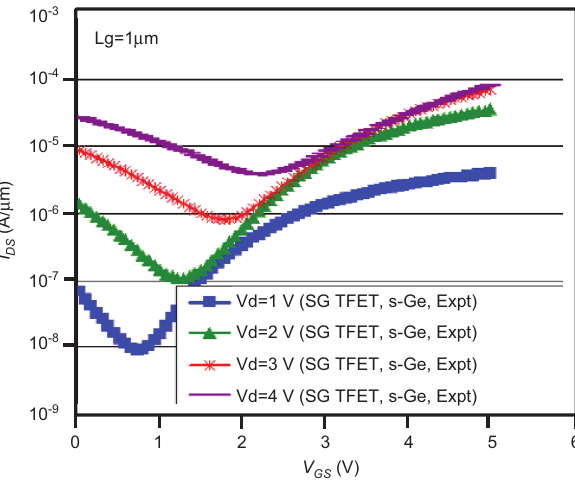
Figure 7 TFETs with symmetric doping and geometry architecture exhibit ambipolar characteristics and show high OFF-state current with negative gate bias. Reprinted from Ref. [32], with permission, from